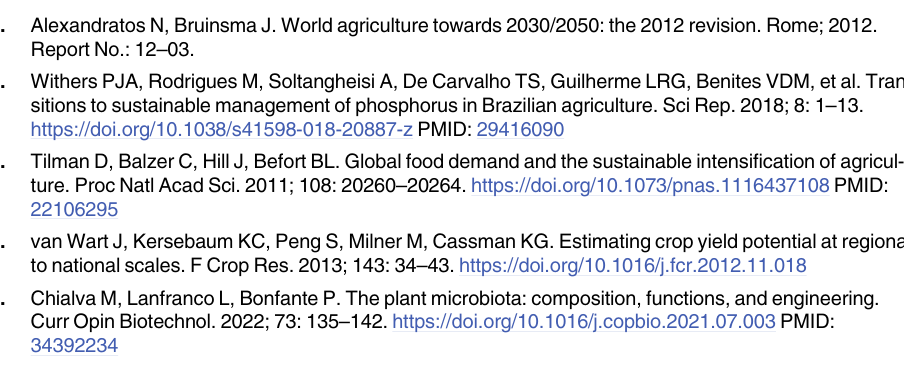
S1 Fig. High-resolution orthoimage showing the aerial view of the experiment.